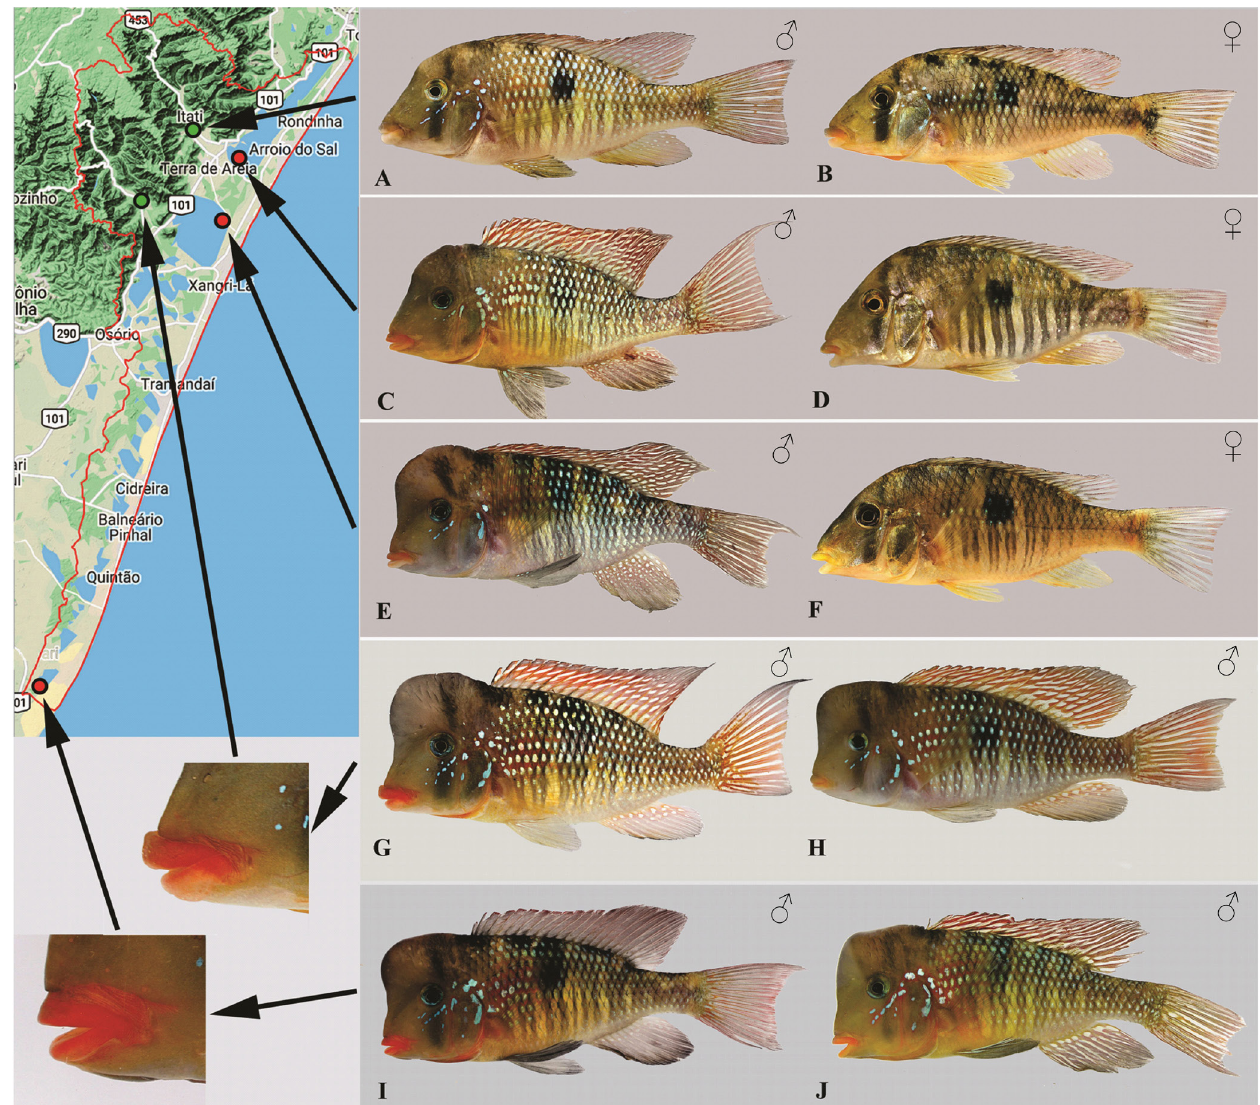
FIGURE 9 | Color pattern in the HBT. A. Male (UFRGS 26300) and B. Female (UFRGS 20302), Três Forquilhas River. C. Male (UFRGS 26311) and D. Female (UFRGS 26311), Itapeva Lake. E. Male (UFRGS 26265) and F. Female (not catalogued), Quadros Lake. G. Male (UFRGS 21101) and H. Male (UFRGS 26264), Maquiné River. I. Male (UFRGS 16751) and J. Male (UFRGS 16751), Bacopari Lake. Specimens A , B , and G , come from rivers draining the mountains (green dots) with rock bottom sharing hypertrophied lips and have been referred to as Gymnogeophagus labiatus HBT. Specimens C ‒ F , H‒J , come from sand bottom environments (red dots) and have been referred to as G. lacustris . Note that specimen H, with undeveloped lips, was collected syntopically with a specimen with hypertrophied lips ( G ). The color pattern of specimens from the currently isolated Bacopari Lake in the southernmost distribution of this species varies from plain dorsal, anal and caudal fins ( I ) to white striped or dotted fins ( J